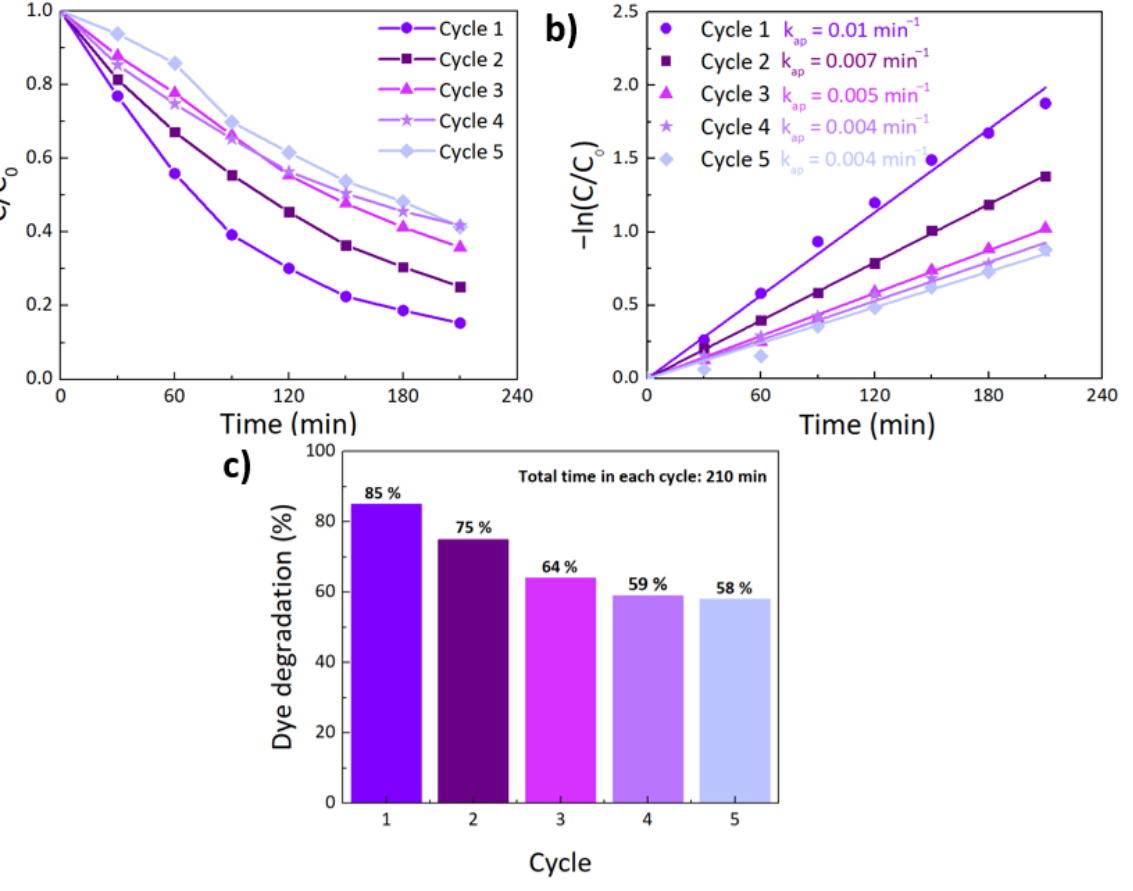
Figure 12. ( a ) Different cycles of RhB degradation ratio (C/C 0 ) vs. exposure time for 5 mol % of Fe ‐ TiO 2 on the porous substrate, ( b ) pseudo ‐ first ‐ order kinetics for RhB photocatalytic degradation of the impregnated investigated substrate (with 5 mol % of Fe ‐ TiO 2 ), and ( c ) reusability of 5 mol % of Fe ‐ TiO 2 over three degradation cycles under solar simulator light.